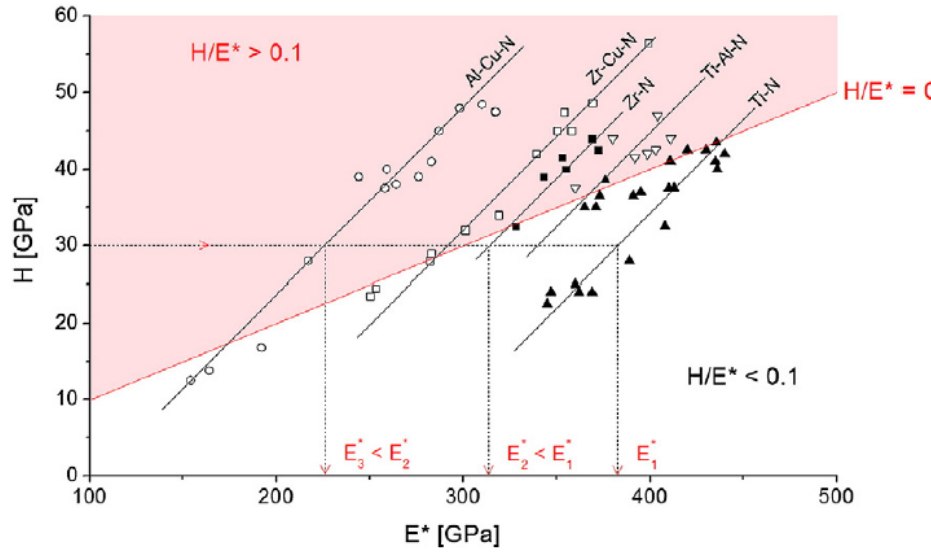
Figure 8: Control of E* and H of different binary nitrides [27]